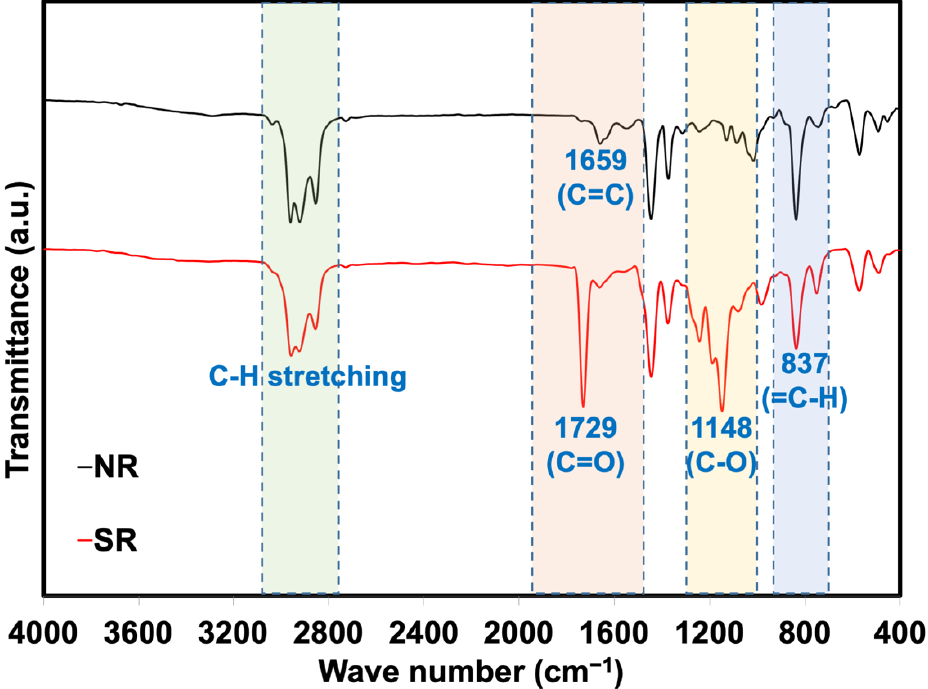
Figure 1. FTIR spectra of NR and SR.